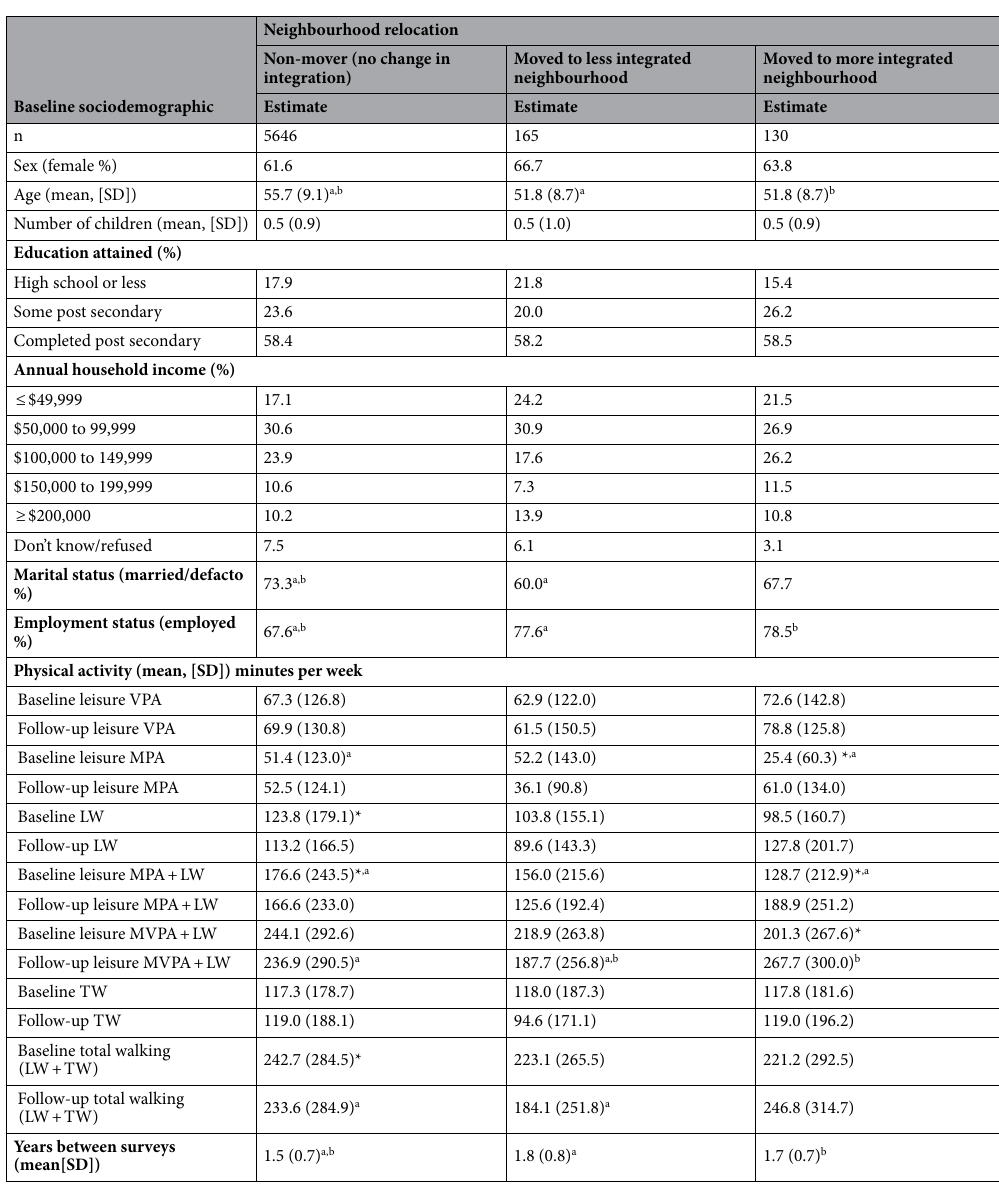
Table 1. Sample characteristics by neighbourhood street integration group (n = 5944). MPA: moderate- intensity physical activity. VPA: vigorous-intensity physical activity. MVPA: moderate-to-vigorous intensity physical LW: leisure walking. TW: transportation walking. Differences in continuous variables by neighbourhood relocation compared using Welch’s ANOVA with Dunnett T3 post hoc tests. Differences in categorical variables by neighbourhood relocation compared using Pearson’s chi-square. Same superscript ( a,b ) represents statistically significant (p < .05) difference between neighbourhood relocation groups. *Statistically significant (p < .05) difference between baseline and follow-up physical activity within neighbourhood relocation group (paired